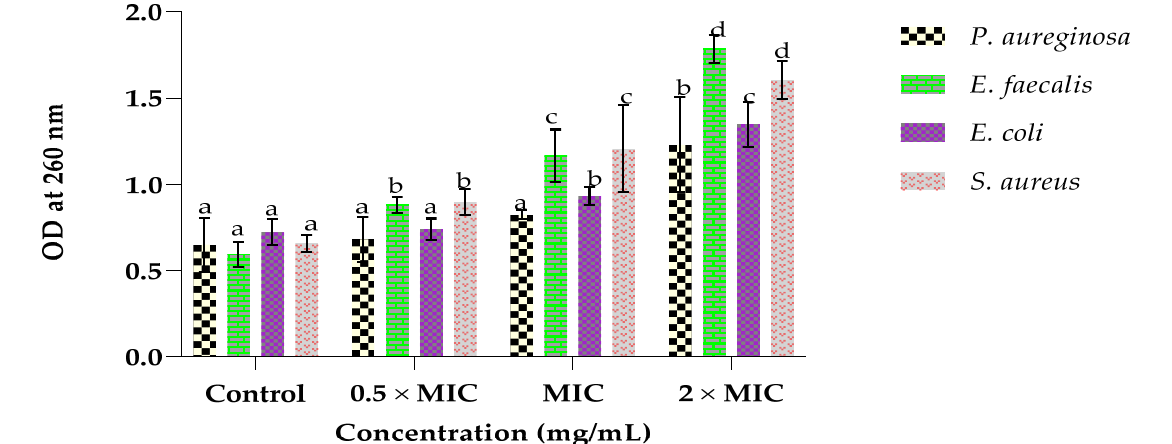
Figure 2. Effect of the whole leaf extract on the release of 260 nm absorbing materials by P. aeruginosa , E. faecalis , E. coli and S. aureus . The different superscripts (a, b, c and d) represent the statistical difference ( p < 0.05) per bacterium; similar letters indicate no statistical difference ( p > 0.05).